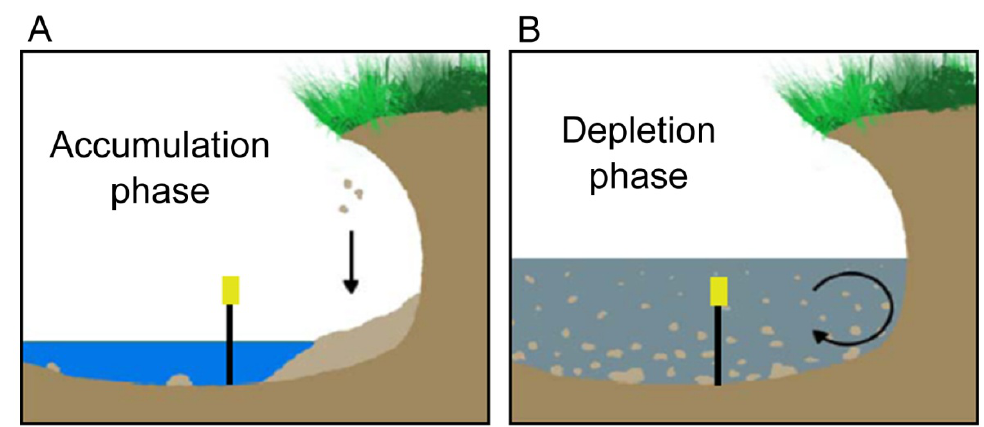
Figure 6. A conceptual model of localized sediment processes consisting of ( A ) an accumulation phase and ( B ) a depletion phase.